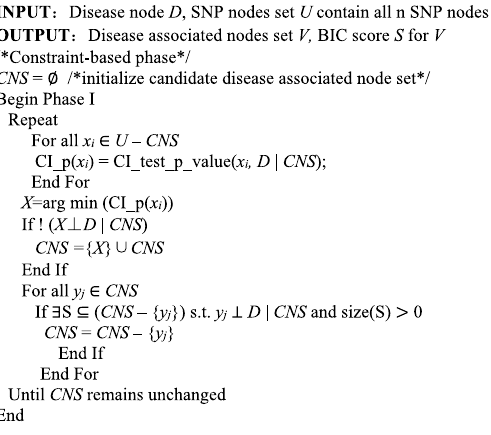
TABLE 1 STS-BN algorithm.